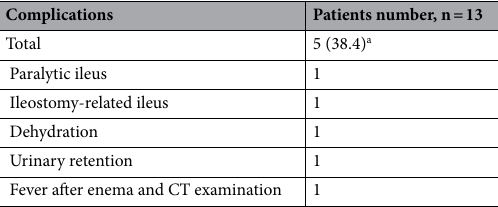
Table 2. Postoperative complications after LAR. a The number in the parenthesis is percentage. CT computerized tomography.